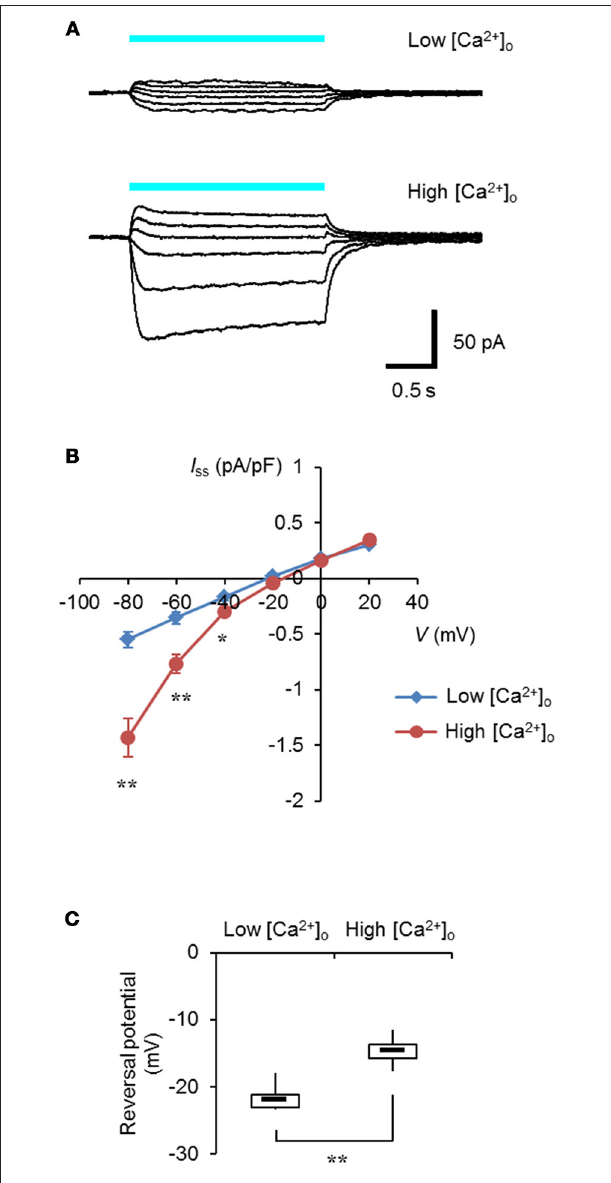
FIGURE 1 | Ca 2 + -permeability of ChRGR. (A) Light-evoked whole cell currents from a ND 7/23 cell expressing ChRGR in a extracellular solution (pH 8.4) containing 0.1mM [Ca 2 + ] o (Low, top traces; whole cell capacitance = 37 pF), or from another cell with 10mM [Ca 2 + ] o (High, bottom traces; 39 pF), both at holding potentials of − 80, − 60, − 40, − 20, 0, and 20mV. Each cyan line shows the timing of the irradiation (475 ± 28nm, 1.3 mWmm − 2 ). (B) The current-voltage (I-V) relationship of the steady-state photocurrent ( I ss ). Mean ± SEM (Low: n = 6, High: n = 7) after standardized by the cell capacitance and expressed as pA/pF. (C) Box-and-whisker plots comparing the reversal potential between Low ( n = 6) and High ( n = 7) [Ca 2 + ] o . * P < 0.05 and ** P < 0.005, Mann-Whitney U